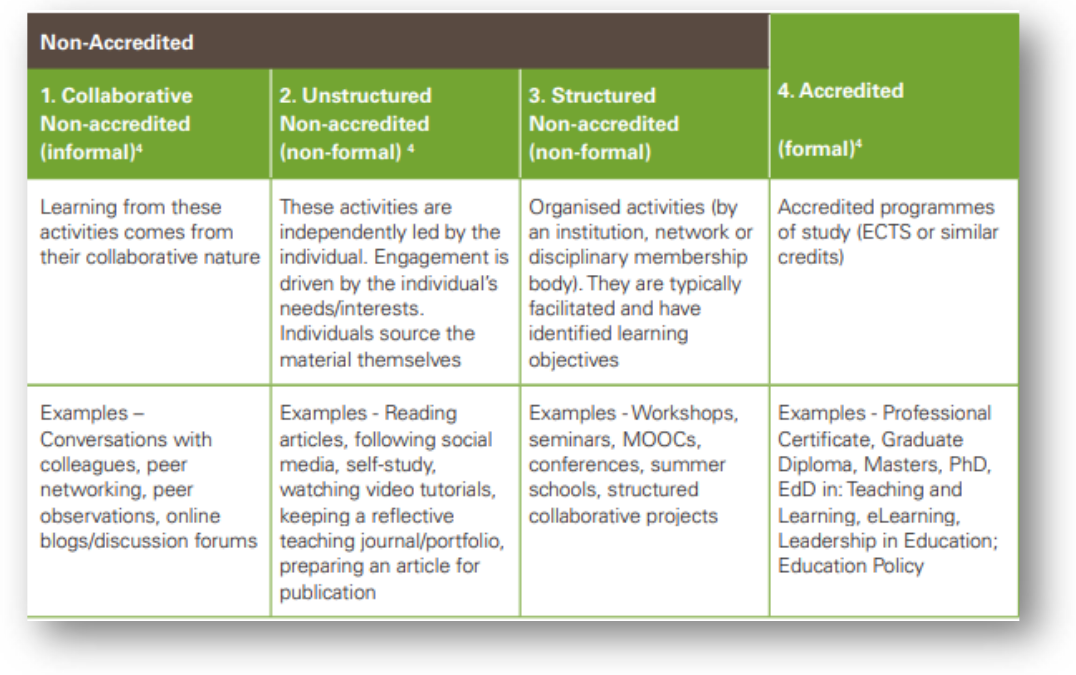
Fig 2: Typologies of the National Professional Development Framework for All Those Who Teach in Higher Education. The PACT course is structured, non-accredited, non-formal (National Forum, 2016,